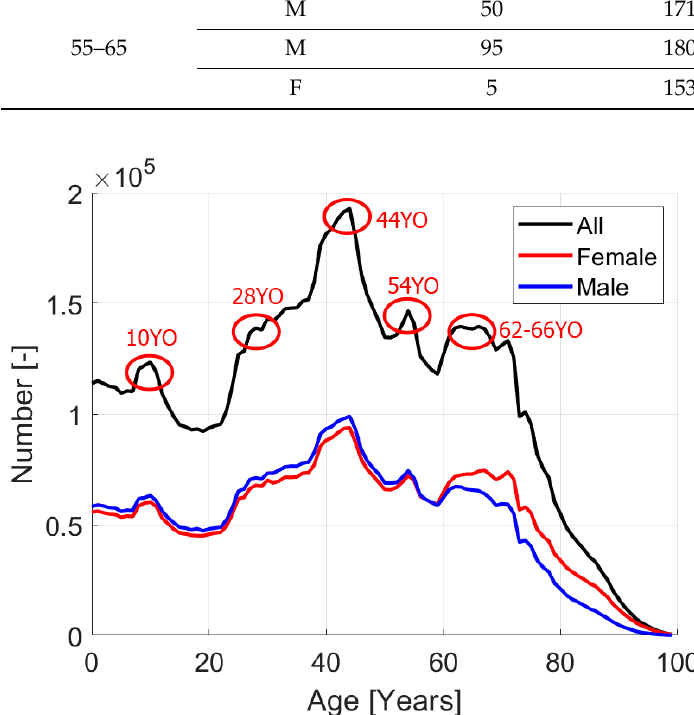
Table 1. Selected occupant anthropometries of Virthuman model.